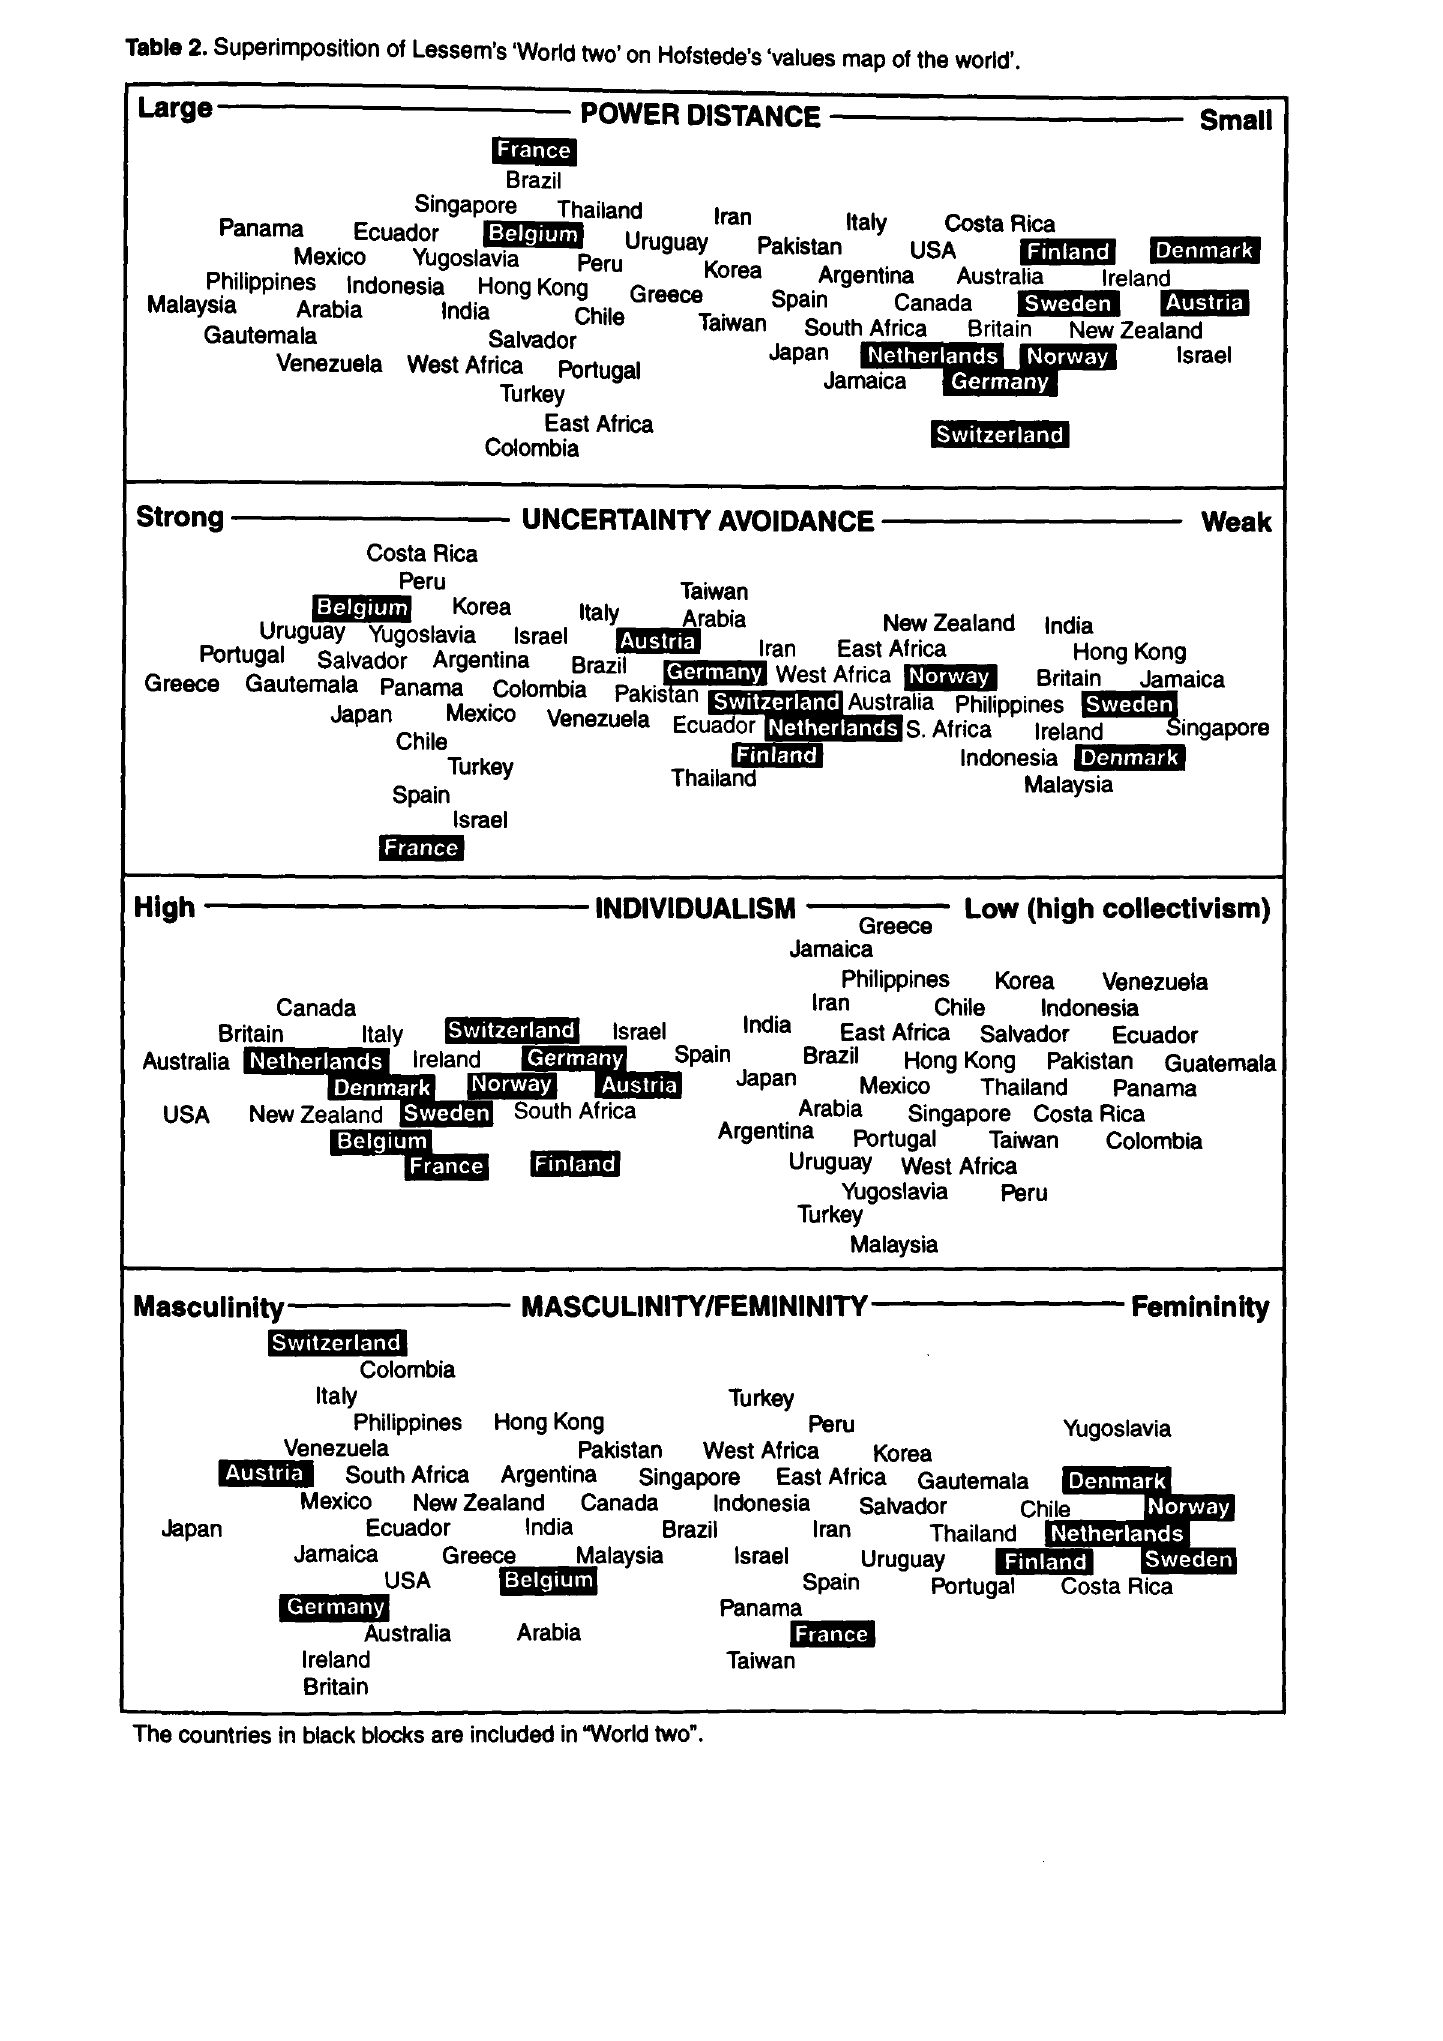
Table 2. Superimposition of Lessem's 'World two' on Hofstede's 'values map of the world'. Large--------- POWER DISTANCE--------- Small